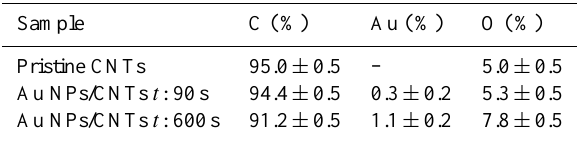
Table 1. XPS surface chemical composition of pristine and Au- functionalized CNTs.